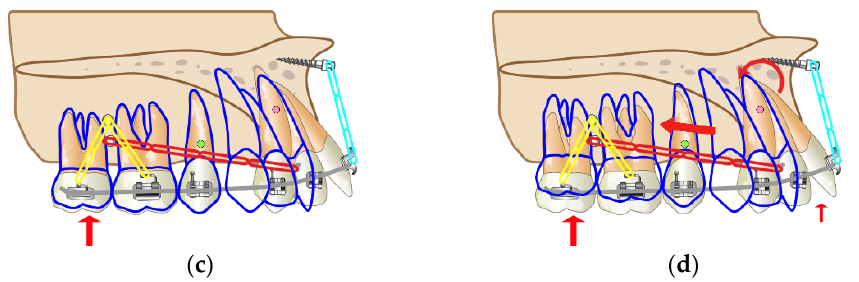
Figure 3. Treatment mechanics: ( a ) TSADs were implanted between the maxillary first and second molars for absolute anchorage. During the retraction of the anterior segment, the moment is produced at the distance between the center of resistance (the point in the alveolus between the maxillary lateral incisors and canines) and the retraction forces for the anterior segment, which led to the clockwise rotation of the anterior teeth. Since the entire dentition was connected with a continuous heavy archwire, clockwise rotation of the full maxillary dentition occurred at the center of resistance, generally located 11 mm apical to and 26.5 mm posterior from the incisal edge of the maxillary central incisor, which resulted in the mild intrusion of the maxillary molars. ( b ) For additional root moment and palatal root movement of the anterior teeth, 100 g of distointrusive force passed through the center of resistance of the full maxillary arch with the help of a single TSAD installed beneath the ANS. ( c ) Additional TSADs for the intrusion of posterior teeth were implanted between the first and second molars on the palatal side. ( d ) The final treatment mechanics.